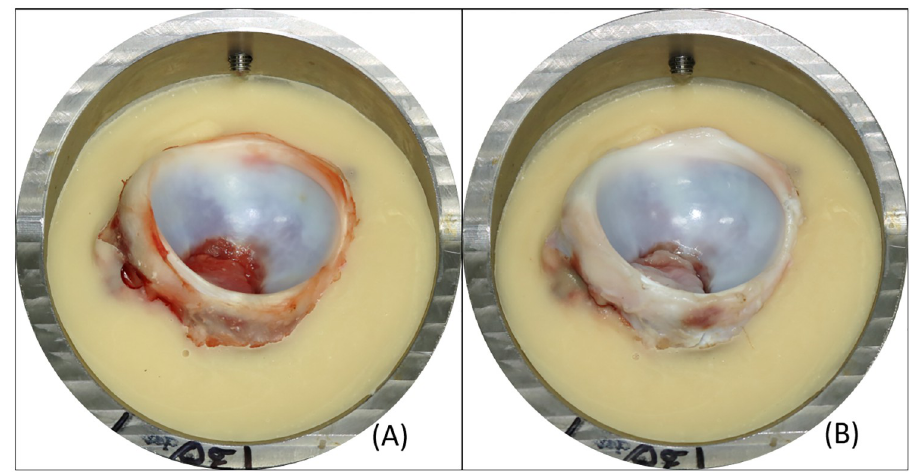
Fig 10. Photogrammetry of the acetabulum. Example images demonstrating (A) pre- and (B) post-test appearance of the samples for testing under normal (NOR) conditions.